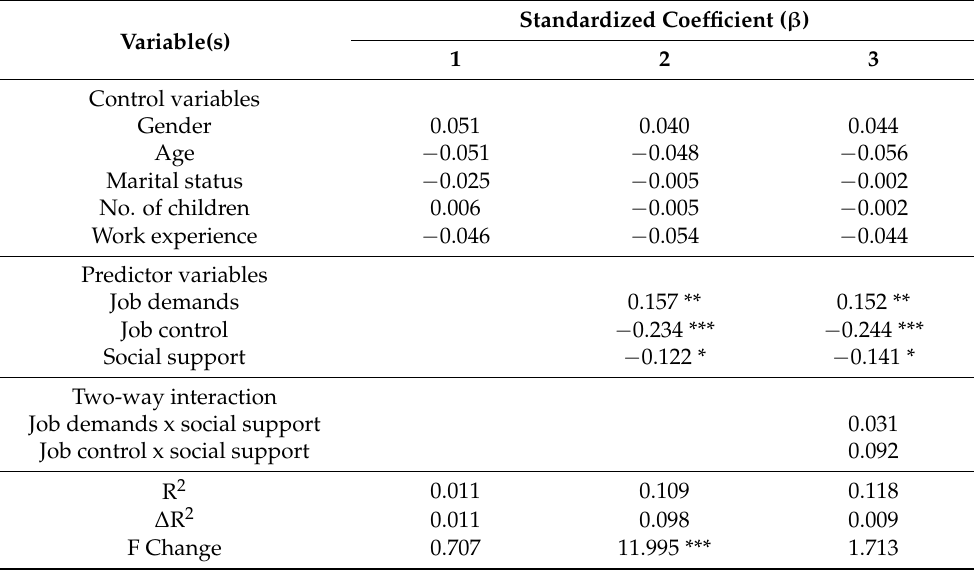
Table 9. The results of hierarchical linear regression model in predicting